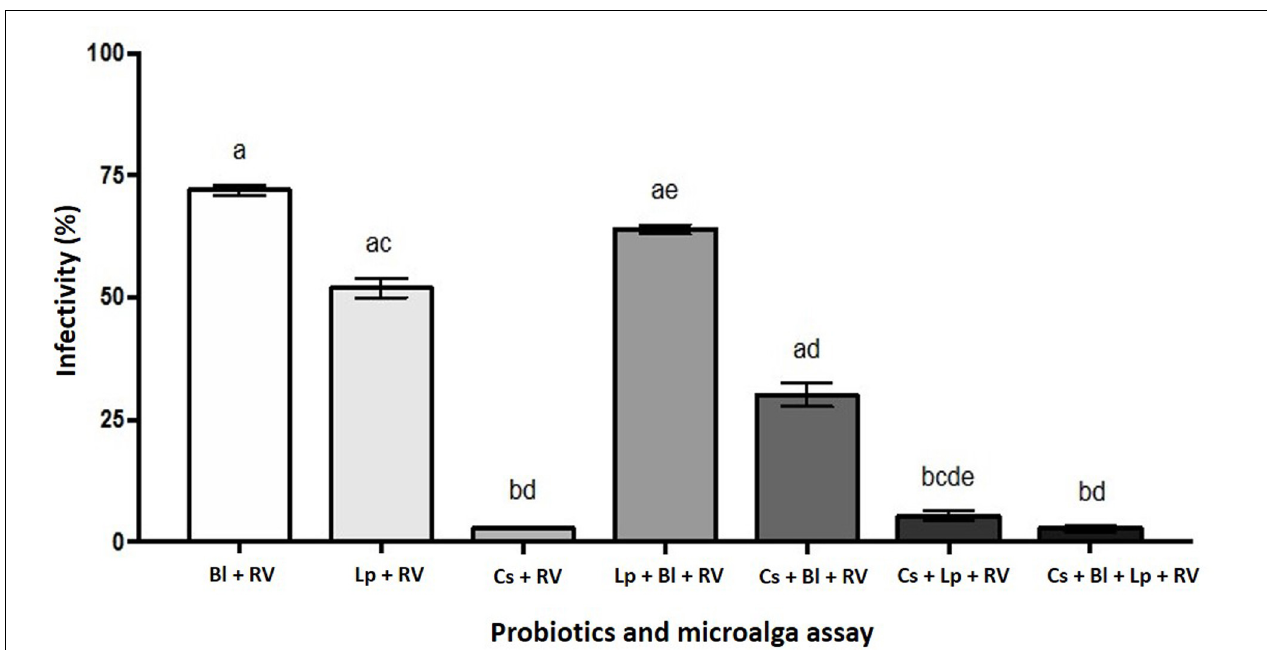
FIGURE 4 | B. longum , L. plantarum , and/or C. sorokiniana metabolites against rotavirus. Assays were performed in HT-29 cells, whereas viral titers were determined in MA104 cells. Viral titers of each assay were calculated as FFU/mL; viral infectivity percentage was estimated considering rotavirus titers in infected cells without any treatment as 100% infectivity. RV, rotavirus; Bl, Bifidobacterium longum ; Lp, Lactobacillus plantarum ; Cs, Chlorella sorokiniana. Different letters indicate statistical significances among treatments. Gray letters represent the control, black letters indicate probiotics (1 × 10 9 ) + C. sorokiniana (1 × 10 6 ), and bold black represent probiotic s (1 × 10 9 ) + C. sorokiniana (1 × 10 9 ), CFU/g. Data were analyzed by Kruskal-Wallis with subsequent Dunn’s test using GraphPad Prism